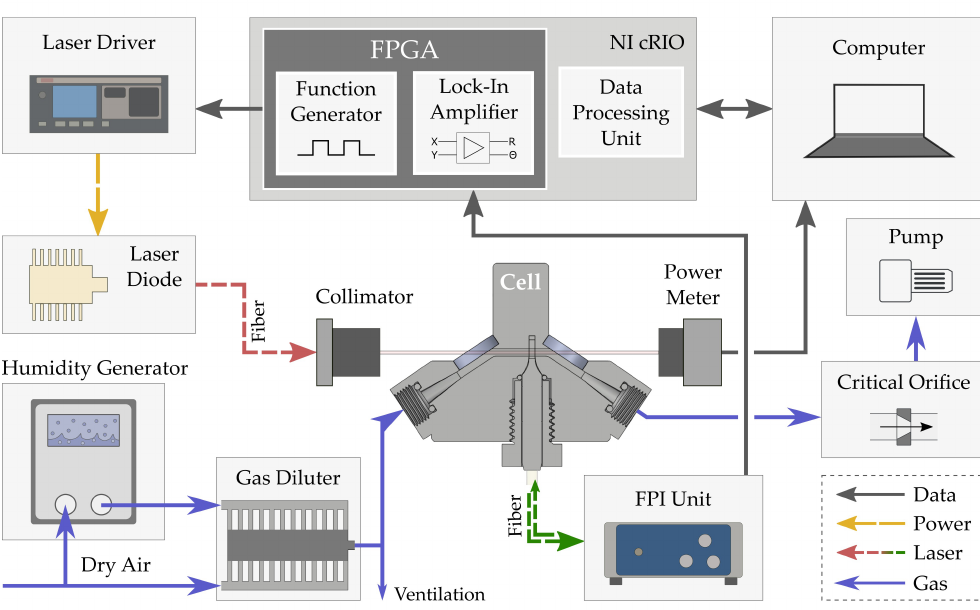
Figure 3. Schematic sketch of the experimental setup with its key components for the modulation frequency sweep. Gas with a predefined water concentration and flow rate is pumped through the cell (solid blue arrows). Periodic temperature change inside the excitation channel, induced by the absorption of the modulated excitation laser (dashed yellow and red arrows), is monitored interferometrically (dashed green arrows). Processing the FPI signal and controlling the laser modu- lation are accomplished via an FPGA that is part of a real-time computing device (NI cRIO, National Instruments). Solid gray arrows denote the essential data